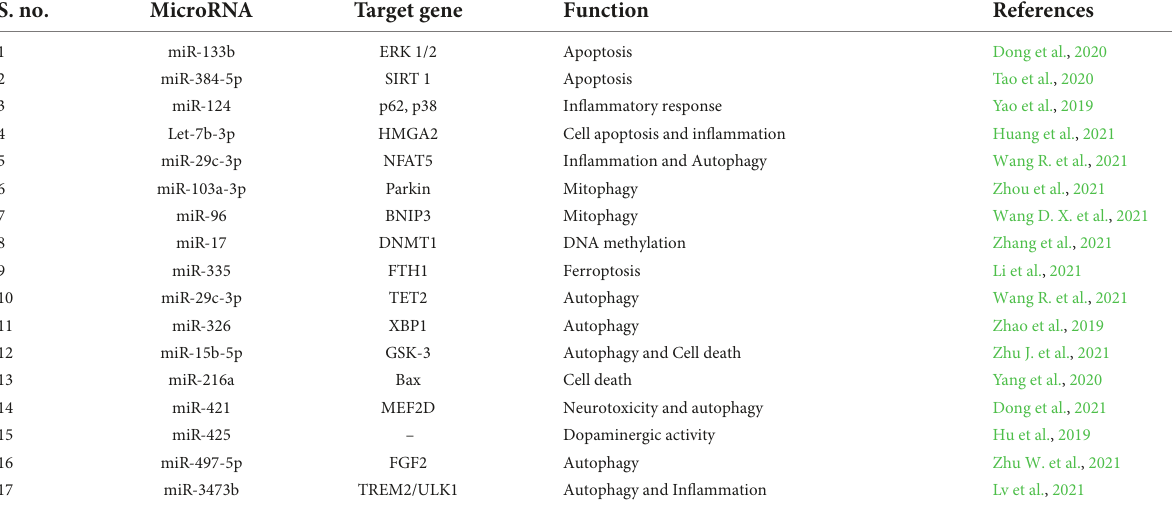
TABLE 1 miRNAs involved in the signaling pathways of Parkinson’s disease. S.